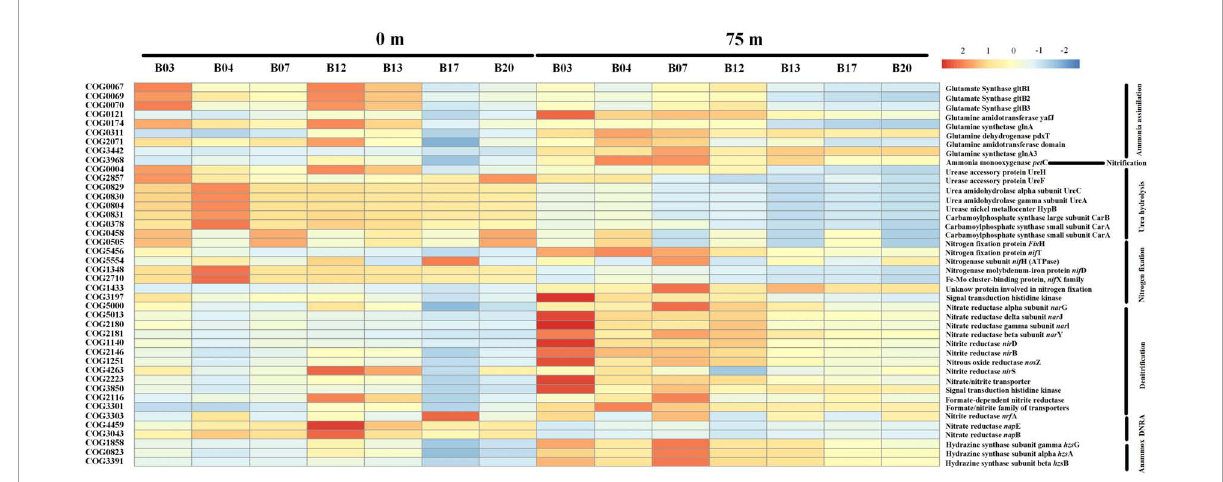
FIGURE6 Heat map showing the relative abundance of different nitrogen metabolic enzymes and their corresponding genes based on the COG database. Notably, the relative abundance of the predicted proteins was log-transformed in the